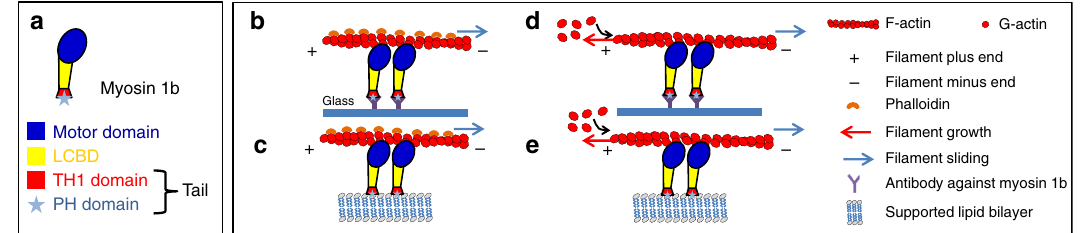
Fig. 1 Myo1b-Actin gliding assays. a Schematic representation of domain organization of Myo1b. Motor domain (blue); Light Chain Binding Domain (LCBD) (yellow); TH1 domain (red), PH domain (cyan) that binds phosphoinositides. b – e Gliding assays of stabilized actin fi laments ( b – c ) and polymerizing actin fi laments ( d – e ) sliding on Myo1b anchored on coverslip ( b – d ) or bound to a supported lipid bilayer ( c – e